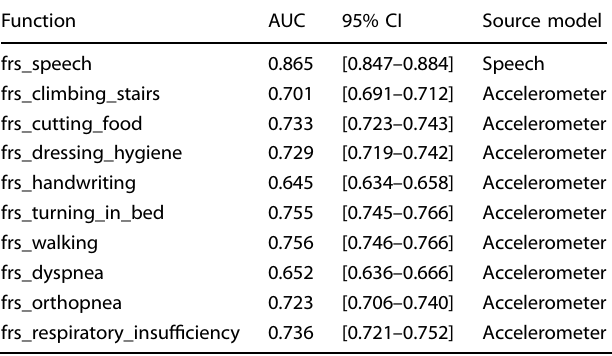
Table 2. AUC Values for predicted ALSFRS-R Scores: AUC values for the predicted ALSFRS-R scores for speech, and 6 functions related to limb movement using the voice (small CNN) model and accelerometer (FFT 1 Hz MLP multi-label) model described in the Methods section. Con fi dence intervals (95% CI) were calculated by bootstrapping. Results for other models are reported in Supplementary Table